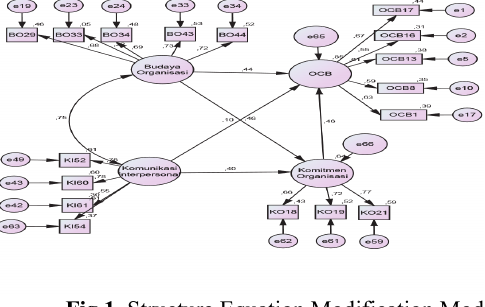
Fig.1. Structure Equation Modification